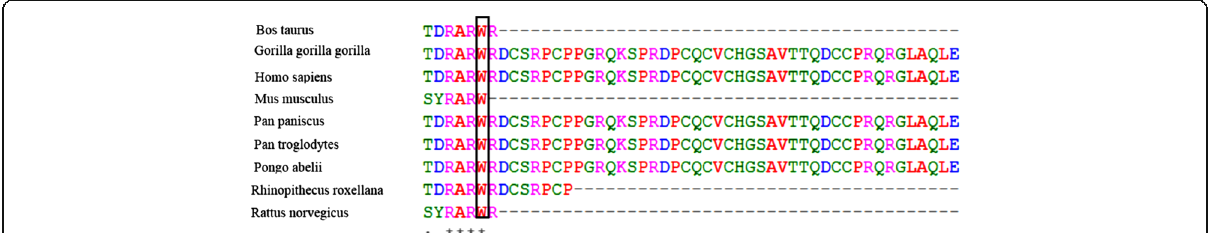
Fig. 3 Comparative amino acids alignment of perforin protein across all Kingdoms. The W374 residue is highly conserved during evolution. The conserved tryptophan residue is shown in the rectangular box . Protein sequences were obtained from National Center for Biotechnology (NCBI). Symbols: (*) — identical amino acids; (:) — just similar amino